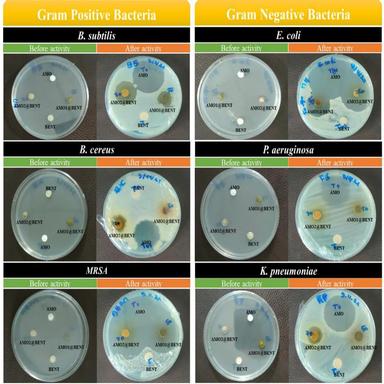
Digital images obtained before and after antibacterial tests of AMO, BENT, AMO1@BENT and AMO2@BENT materials against gram-positive and negative bacteria.